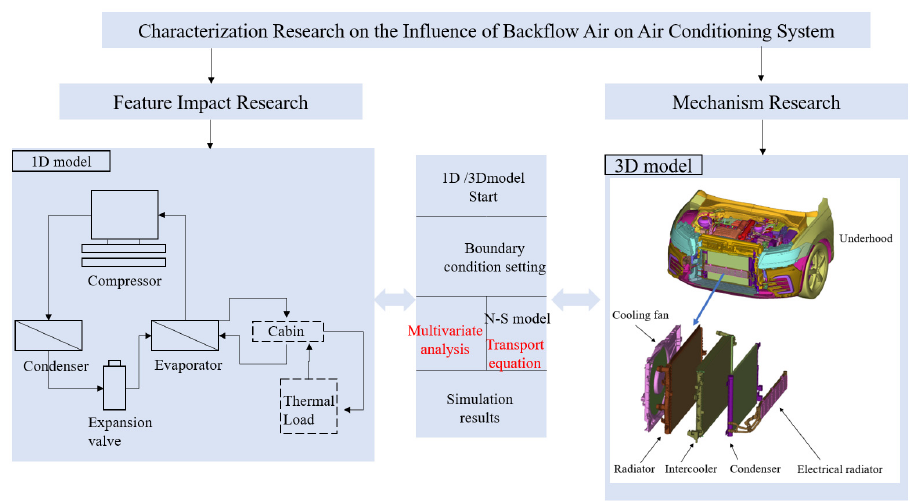
Figure 1. Research framework of the air backflow effect in the underhood of PHEV.